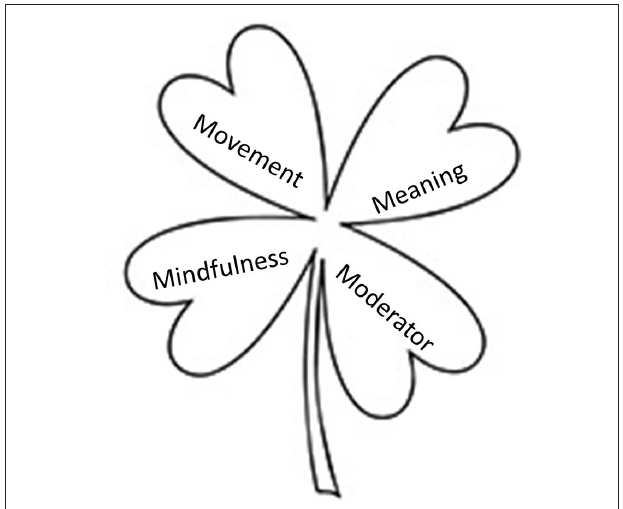
FIGURE 2 | The 4M-Model generated from this study’s qualitative synthesis, visually illustrated as a four-leaf clover which is a symbol of luck. Promoting university students’ mental health: a systematic literature review introducing the 4M-Model of individual-level interventions, Dubai, United Arab Emirates,